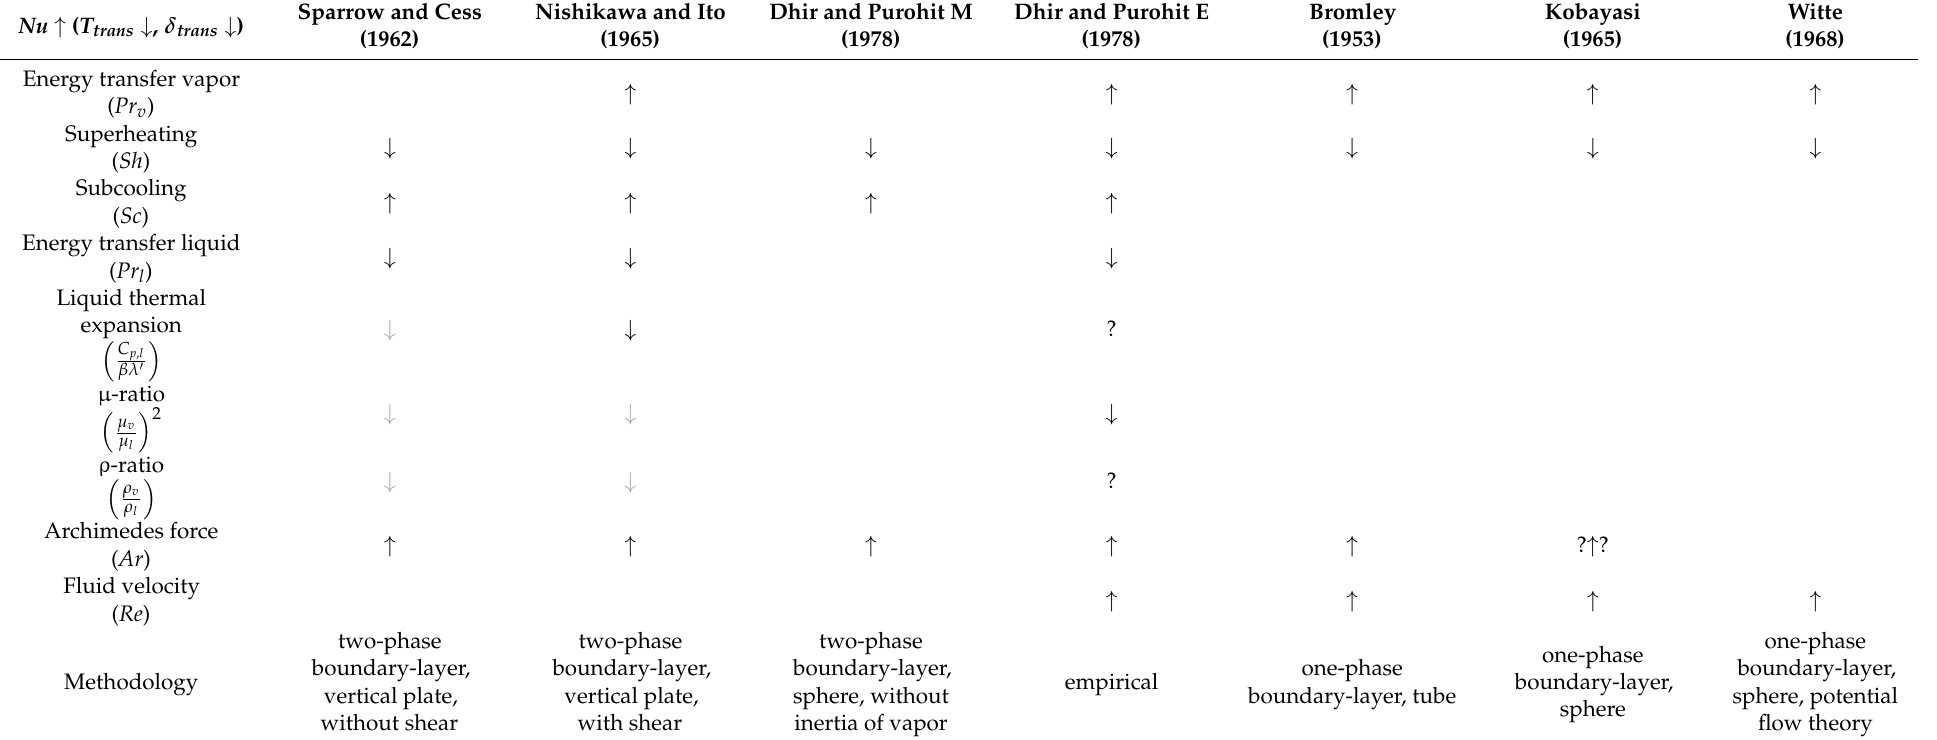
Table 2. Overview of the used influence parameters in the different models for Nu (Dhir and Purohit; M and E refers to their theoretical model and empirical relation, respectively); clear: not considered in model, grey arrow: considered as a combination of multiple parameters, black arrow: considered by itself; arrows show the effect on Nu (up = positive correlation, down = negative correlation; only when present in final results (figures/formulas)); ? refers to the assumed typographical error in the formulas for the empirical relation obtained by Dhir and Purohit